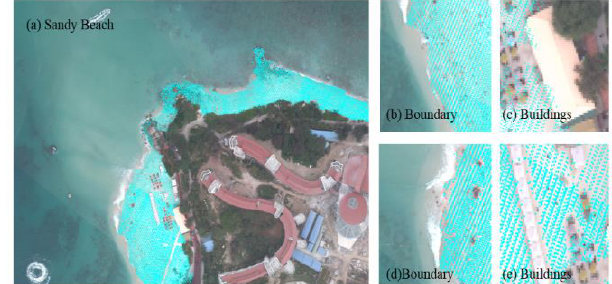
Figure 11: Extraction result of sandy beaches: (a) part of the sandy beaches; (b) (d) Enlarged view which suggested it avoids the influence of buildings; (c) (e) Enlarged view Figure 9: Extraction result of water surface profile: (a) the which suggested the extraction result on boundary. Whole Island water surface profile; (b) Enlarged view of sandy beach water surface profile; (b) Enlarged view of gravel beach water surface profile;